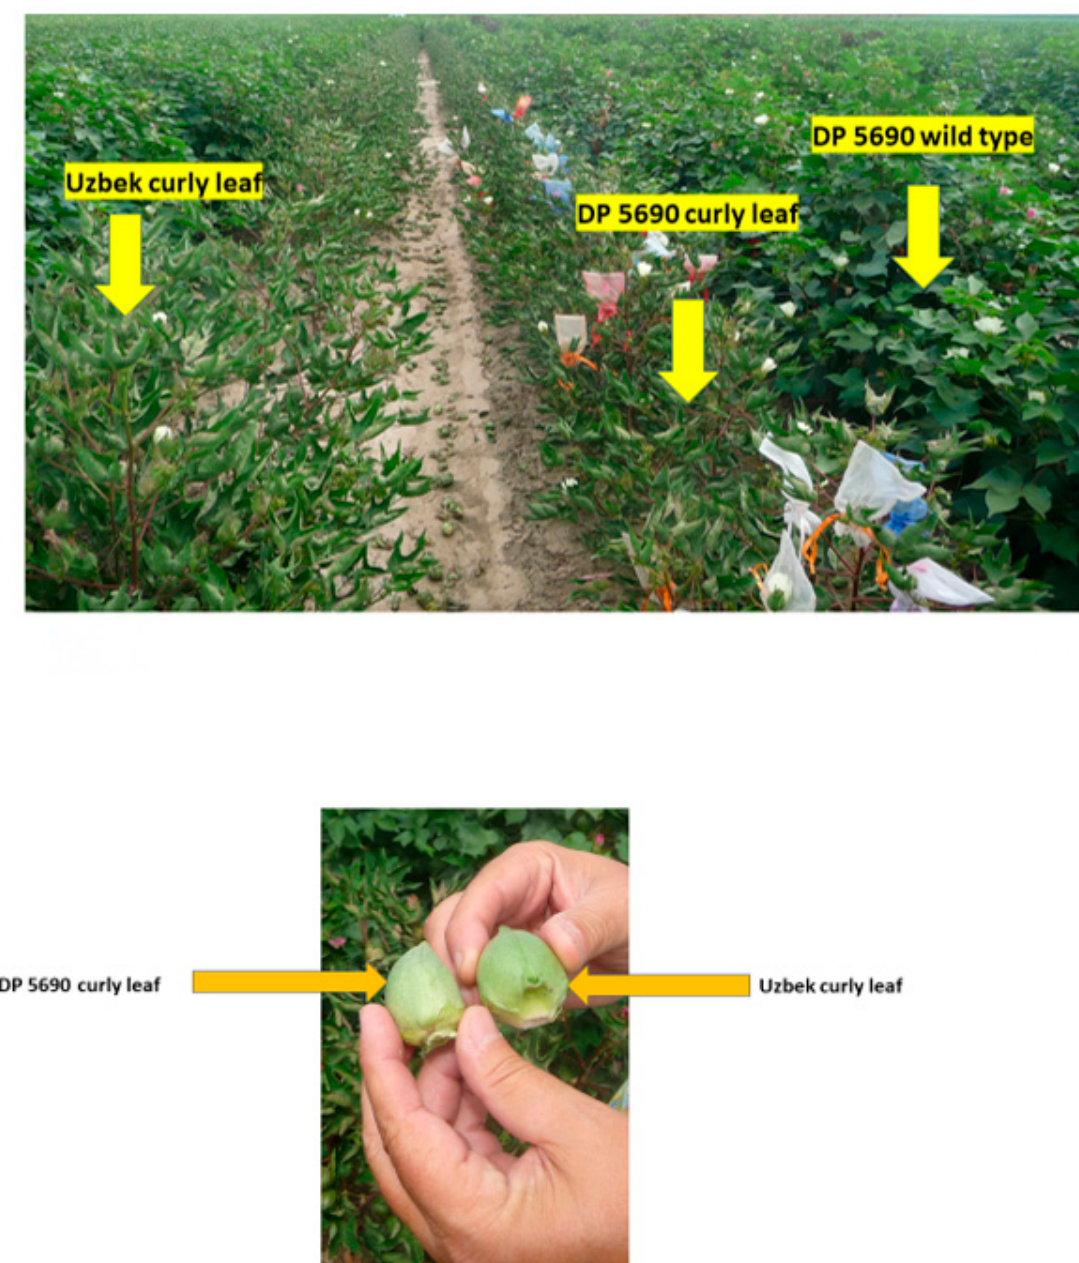
Figure 2. Uzbek curly leaf, DP 5690 wild type (smaller, narrow, rolled-up leaves), and DP 5690 curly leaf lines in the field, top photo; bolls from Uzbek curly leaf (larger) and DP 5690 curly leaf lines (smaller) showing the boll sizes, bottom photo.